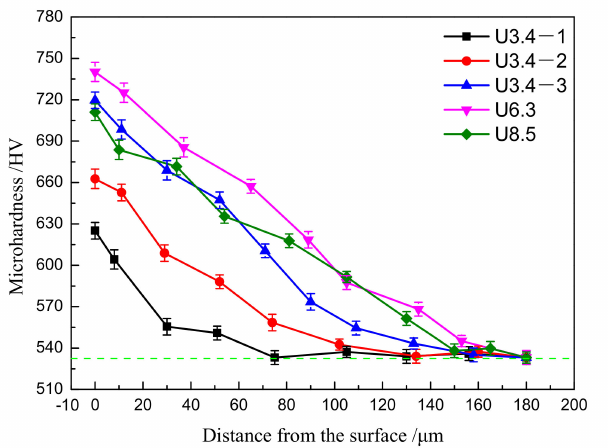
Figure 4. Microhardness of 51CrV4 spring steel specimens at the smallest diameter section under different treatment